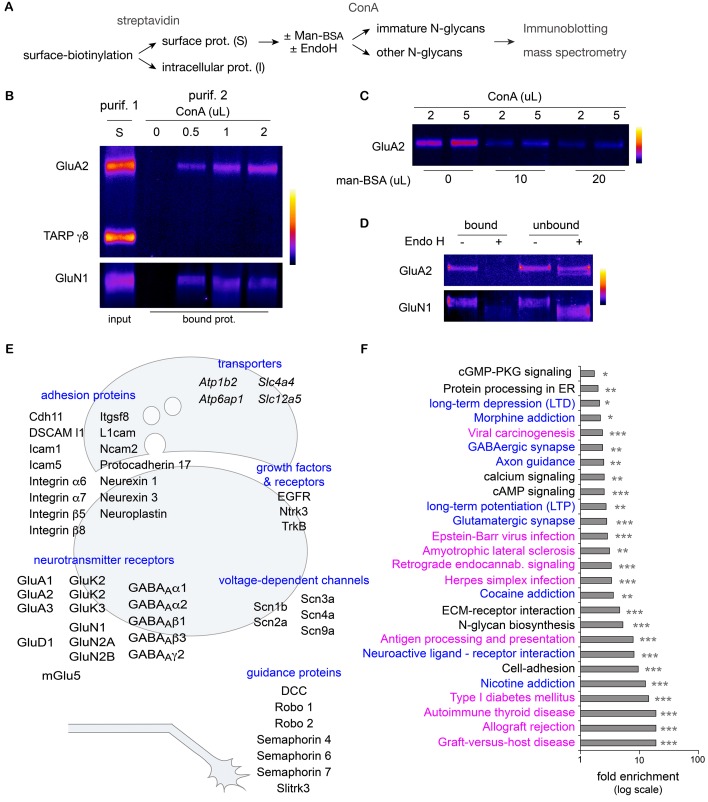
Hundreds of surface neuronal membrane proteins are core-glycosylated.Purification scheme (A) and immunoblots (B–D) showing the isolation of core-glycosylated N-glycans of the neuronal plasma membrane. (B) Presence of GluA2 and GluN1, but not TARP γ8, among proteins binding to ConA (vol. in µL). The lane 'S' shows GluA2, GluN1 and TARP γ8 immunoreactivity in the surface fraction that was used for the experiment. (C) Incubation of surface proteins with ConA in the presence of mannose-BSA (vol. in µL) abolishes GluA2 binding to ConA. (D) Bound and unbound fractions after purification with ConA in control conditions or after protein digestion with EndoH. Core-glycan removal with EndoH abolishes GluA2 and GluN1 binding to ConA. (E,F) Mass spectrometry of proteins purified as in A. (E) Schemes of a synapse and a growth cone highlighting examples of core-glycosylated surface neuronal proteins of particular physiological relevance for synaptic function and neuron development. (F) Fold enrichment of N-glycoproteins included in the indicated pathways in core-glycosylated surface proteins versus total proteins. Highlighted in blue and in purple are proteins of particular relevance for neuronal functions or autoimmune diseases and cancer, respectively. *p<0.05, **p<0.01, ***p<1x10−4, hypergeometric test.